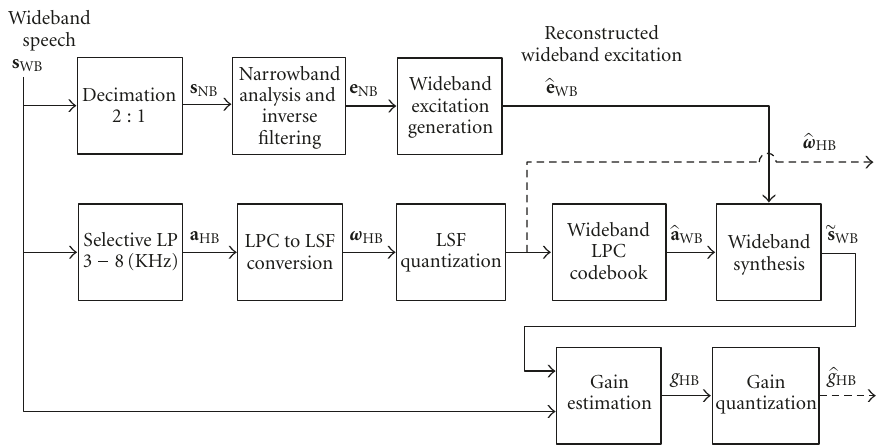
Figure 2: SBE encoder